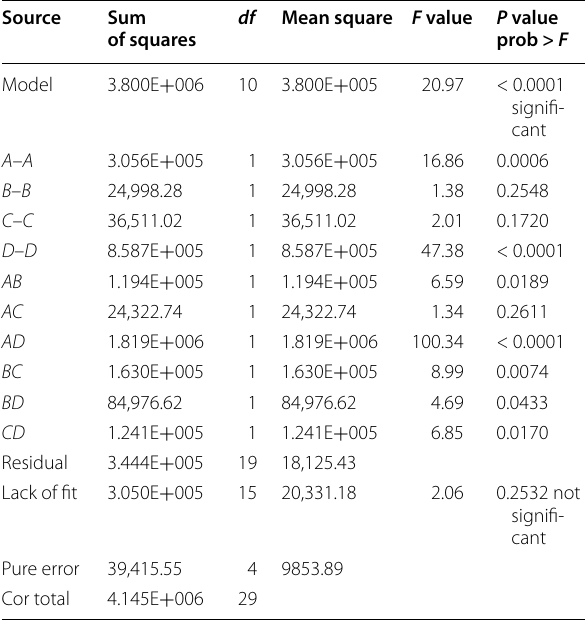
Table 6 Analysis of variance (ANOVA) for amylase quadric model from strain